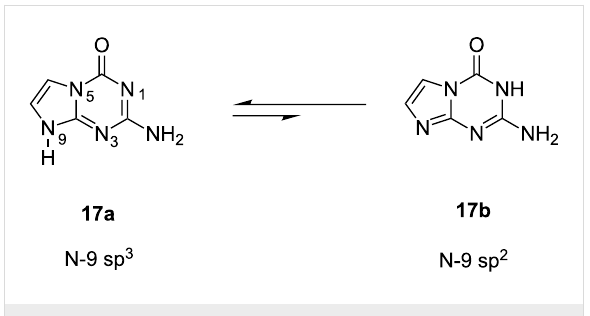
Figure 7: Tautomeric structures of 5-aza-7-deazaguanine ( 17